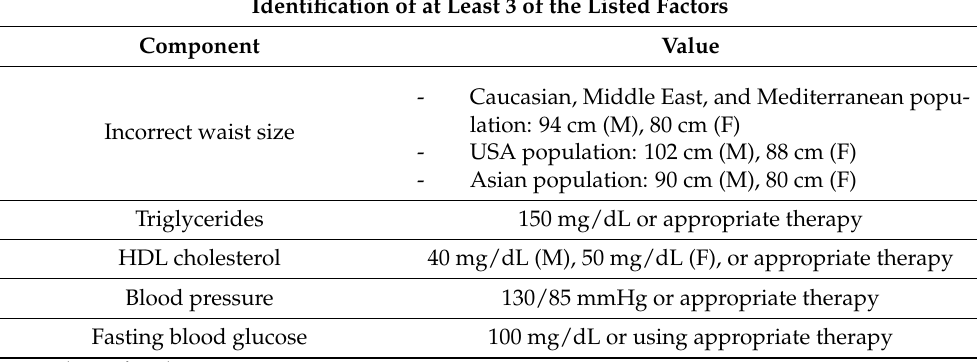
Table 1. Criteria for the diagnosis of metabolic syndrome based on the consensus of the International Diabetes Federation (IDF) and the American Heart Association/National Heart, Lung, and Blood Institute (AHA/NHLBI) from 2009 [44]. Identification of at Least 3 of the Listed Factors Component Value - Caucasian, Middle East, and Mediterranean popu- lation: 94 cm (M), 80 cm (F) Incorrect waist size - USA population: 102 cm (M), 88 cm (F) - Asian population: 90 cm (M), 80 cm (F) Triglycerides 150 mg/dL or appropriate therapy HDL cholesterol 40 mg/dL (M), 50 mg/dL (F), or appropriate therapy Blood pressure 130/85 mmHg or appropriate therapy Fasting blood glucose 100 mg/dL or using appropriate therapy M—male,